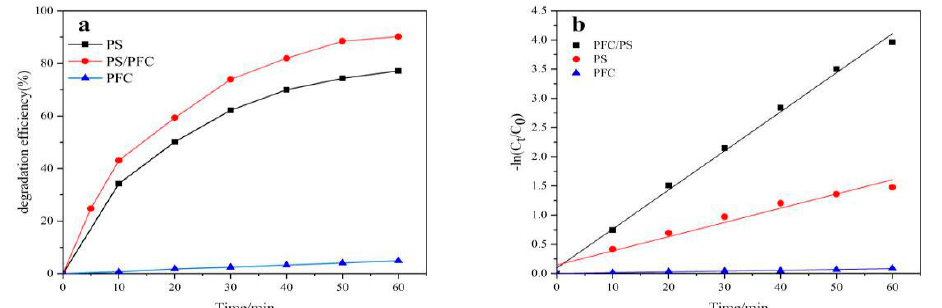
Figure 3. Degredation e ffi ciency of 10 mg / L norfloxacin (NOR) in photocatalytic fuel cell (PFC), persulfate (PS), and PFC / PS system under ultraviolet (UV) light irradiation ( a ) and its pseudo first-order kinetic fit ( b ). Experimental conditions: pH = 3.0, [PS] = 3 mM, and electrolyte: 0.1 M Na 2 SO 4 .